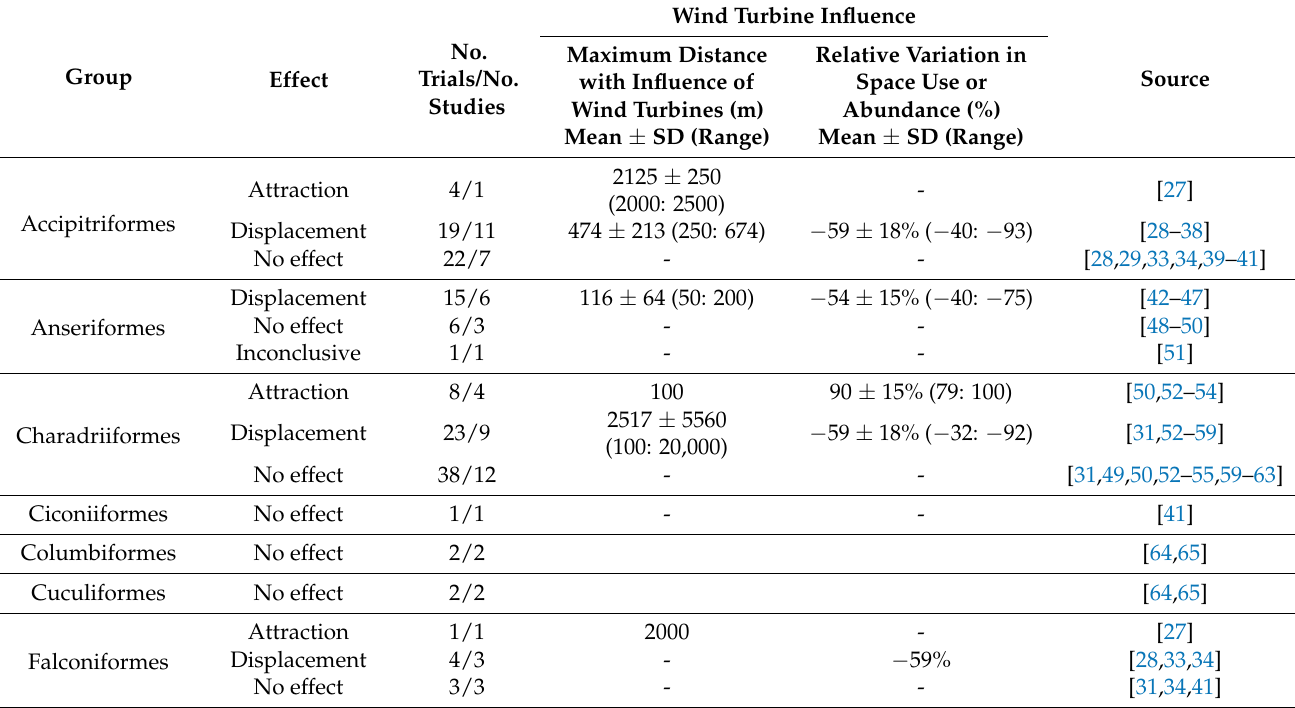
Figure 5. Relative frequency of trials ( n = 286) reporting attraction, displacement or no effects of wind turbines on bird space use or abundance, per birds’ group. The bar width represents the number of experimental trials performed per each birds’ groups. Table 1. Summary of the effects described per bird group in the 286 trials analysed in this review. Note that not all the studies reporting displacement or attraction effects provided the maximum distance or the relative variation of the effect. When there was data available for more than one study, mean values, standard deviation (SD) and range (minimum and maximum values) are presented.